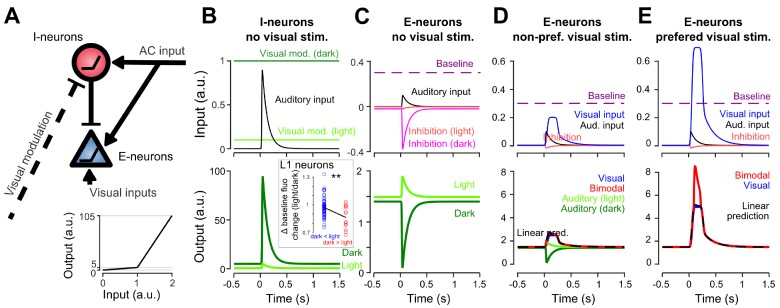
Non-linear inhibitory and excitatory neurons reproduce gated-inhibition and bimodal boosting.(A) Sketch of a minimal model for the switch between negative and positive sound responses in dark vs in light and boost of visual responses to sounds. An inhibitory (I-neurons) population endowed with a non-linear response function (bottom) receives a positive auditory input and a negative visual input. When both inputs are active (lit condition), the auditory drive to I-neurons is below threshold and no inhibition is delivered to the excitatory non-linear neuronal population (E-neurons). In the dark condition, the visual modulation is reduced releasing sound triggered inhibition. Both I- and E-neurons are non-linear with a low and a high output gain. Auditory and visual inputs are typically converted with a low-gain, while coincident auditory and preferred-visual inputs pass the threshold and yield a high-gain output (boosting). (B) Input currents and output response of I-neurons during auditory simulation in light and dark conditions. Inset: Change in baseline fluorescence between light and dark conditions in L1 interneurons. A significant baseline decrease in light is observed for interneurons that are more sound responsive in dark than in light (i.e. putative I-neurons, red) as compared to interneurons that are more responsive in the light (Wilcoxon rank sum test, p=0.00989, n1 = 57 ‘dark <light’ cells, n2 = 14 ‘light <dark’ cells). (C) Same for E-neurons. (D) Input currents and output response of E-neurons during visual simulation alone (blue) and bimodal stimulation for a sub-threshold (non-preferred) visual input. Superimposed are the auditory responses in light and dark from panel (C) (E) Same as in D. but for a preferred, supra-threshold visual input.